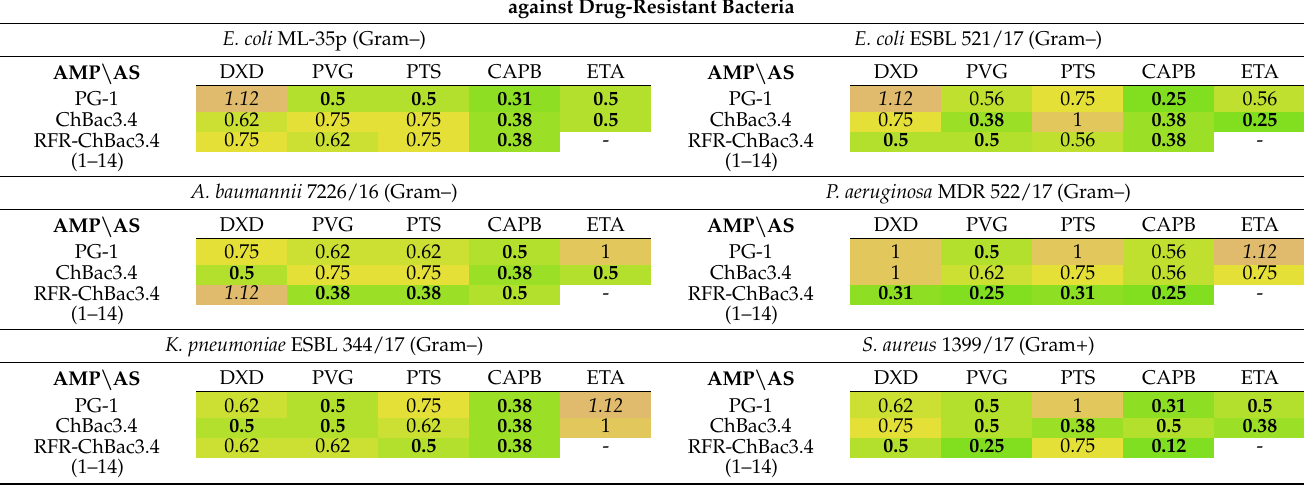
Table 2. Antimicrobial activity of combinations of AMPs with antiseptics and surfactants against drug-resistant clinical isolates and E. coli ML-35p laboratory